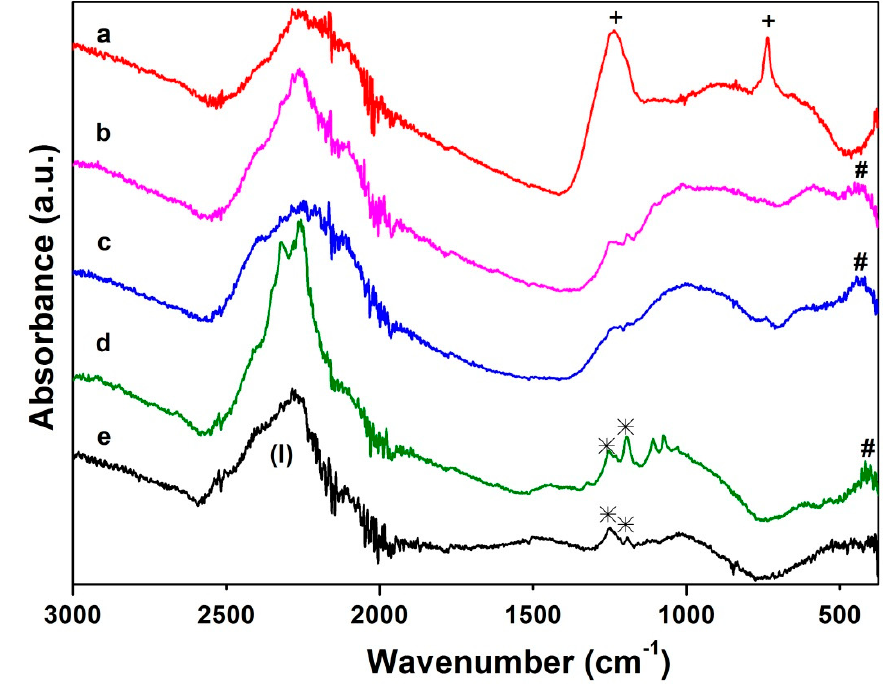
Figure 7. ATR-IR spectra of (a) Ca(BH 4 ) 2 , (b) 1Mg(BH 4 ) 2 : 2Ca(BH 4 ) 2 , (c) 1Mg(BH 4 ) 2 : 1Ca(BH 4 ) 2 , (d) 2Mg(BH 4 ) 2 : 1Ca(BH 4 ) 2 , and (e) Mg(BH 4 ) 2 after thermal cycling (DSC analysis up to 440 °C under 2 bar of H 2 ). For symbols explanations, see the text.